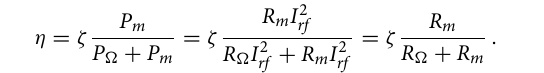
Figure 5. Power transmission efficiency η into the magnetic system( ζ = Damon–Eshbach configuration ( a ) as a function of the inductive antenna width w between 100 nm and 5 µ m ( W = 1 µ m , t = 20nm ) and ( b ) as a function of waveguide thickness t between 10 nm and 50 nm ( W = 1 µ m , w = 300 nm ). The FMR frequency at 8.1 GHz is indicated in both graphs as a